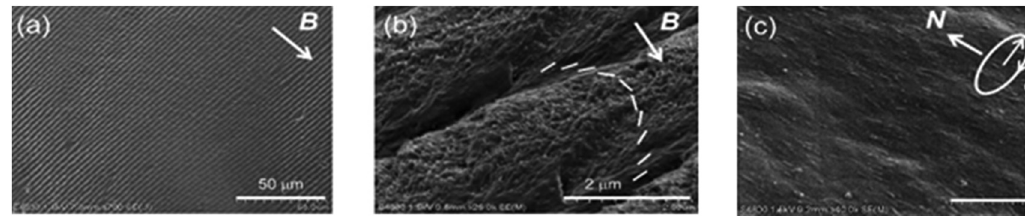
Figure 9: FESEM micrographs of fracture surfaces of polymer nanocomposites ( a ) lower magni fi cation image, ( b ) enlarged view and ( c ) higher magni fi cation image under the in fl uence of an external magnetic fi eld. Adapted from ref. [ 62 ]